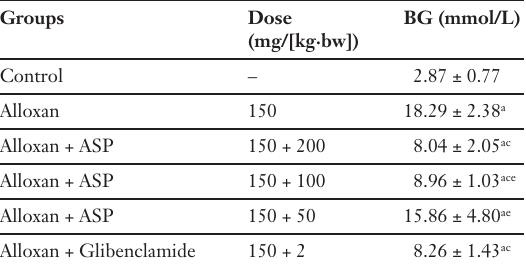
bw (P <0.05) than in the diabetic control group,